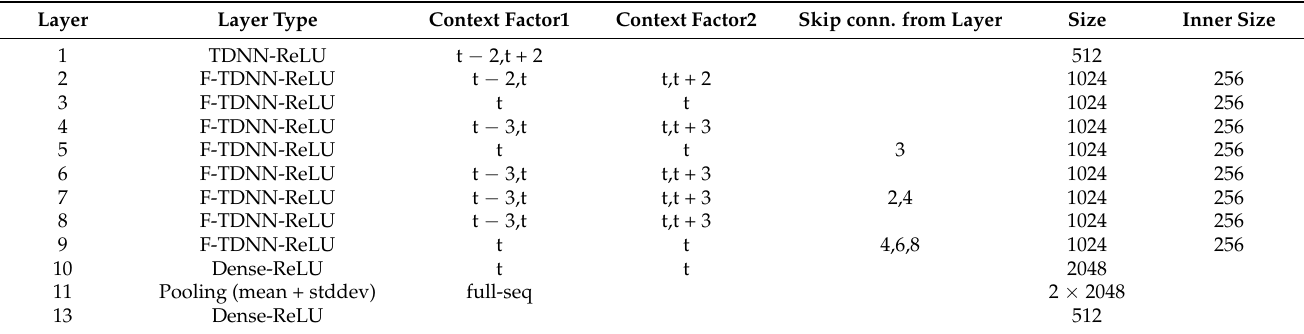
Table 2. Architecture of Factorized-TDNN.